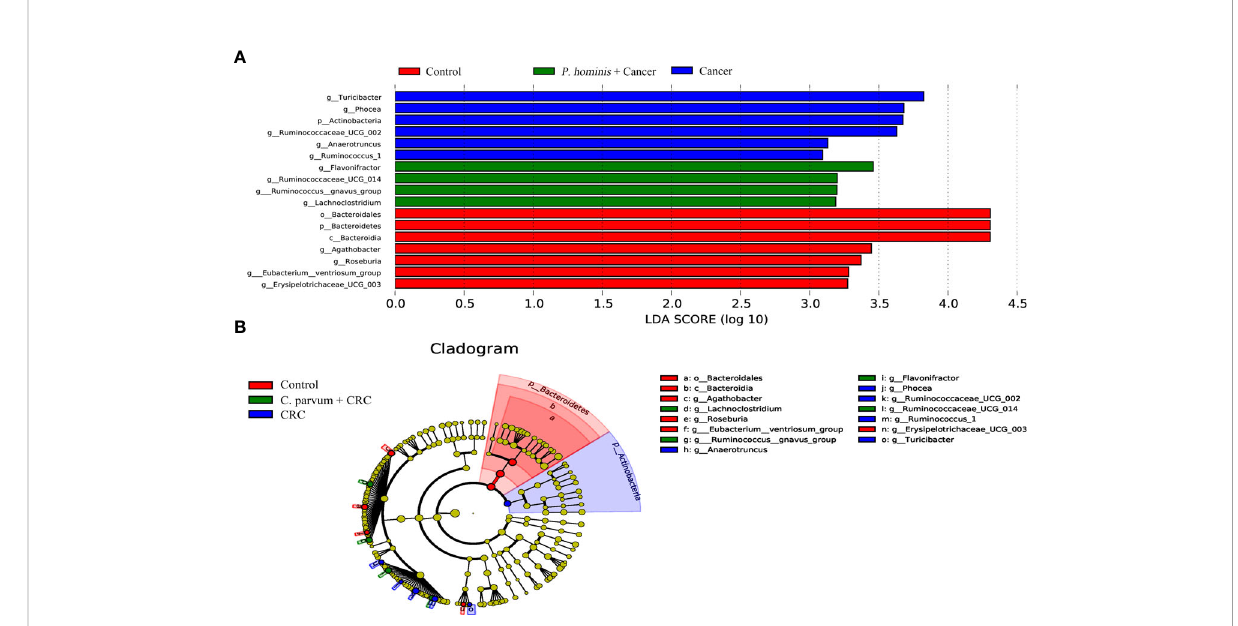
FIGURE 4 The LEfSe algorithm was used to analyze the OTU tables for identifying the taxa that best represented each biological class. (A) Cladogram depicting the phylogenetic distribution of the bacterial lineages in the Control, Cancer, and P. hominis+ cancer groups. (B) Circles from the inside out indicate phylogenetic levels from genus to